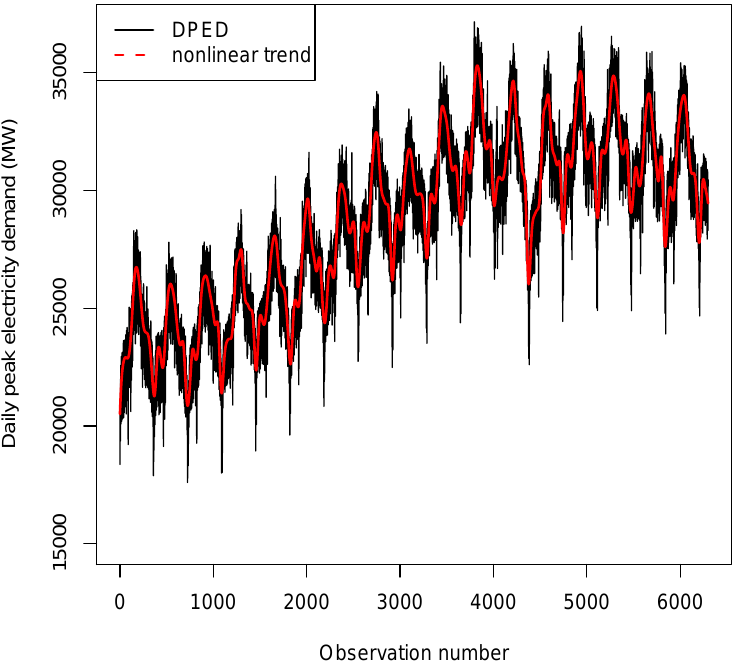
Figure 2. Daily peak electricity demand superimposed with a nonlinear